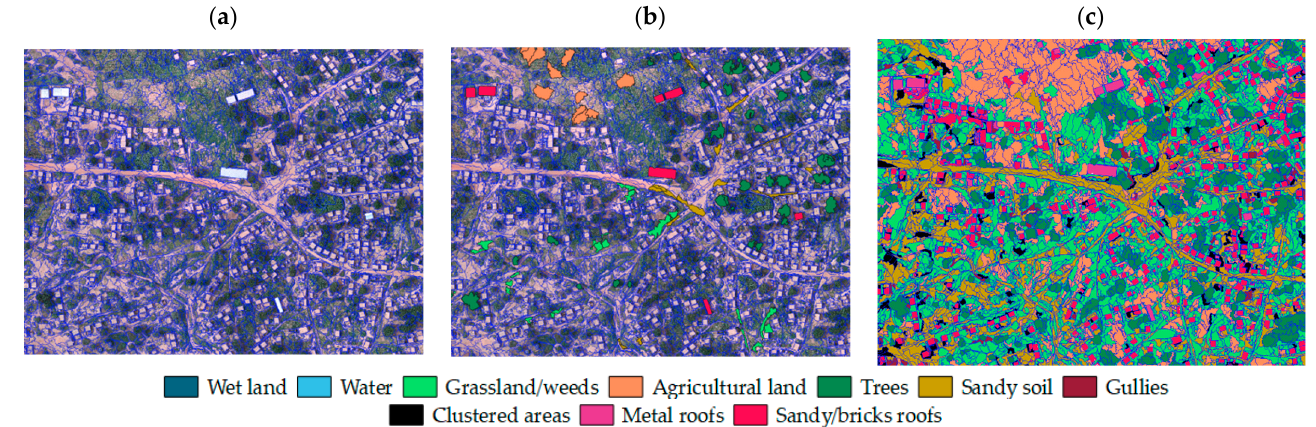
Figure 8. ( a ) Example of segmentation in a sample area, ( b ) training samples and ( c ) classification. The visual assessment revealed a tendency to over-segmenting (14 over-segmented objects against 7 under-segmented objects), Table 5. Of the houses, 84% were detected (112 matches over 133 references). The F1 score, which related user’s and producer’s accuracies, was 70%.